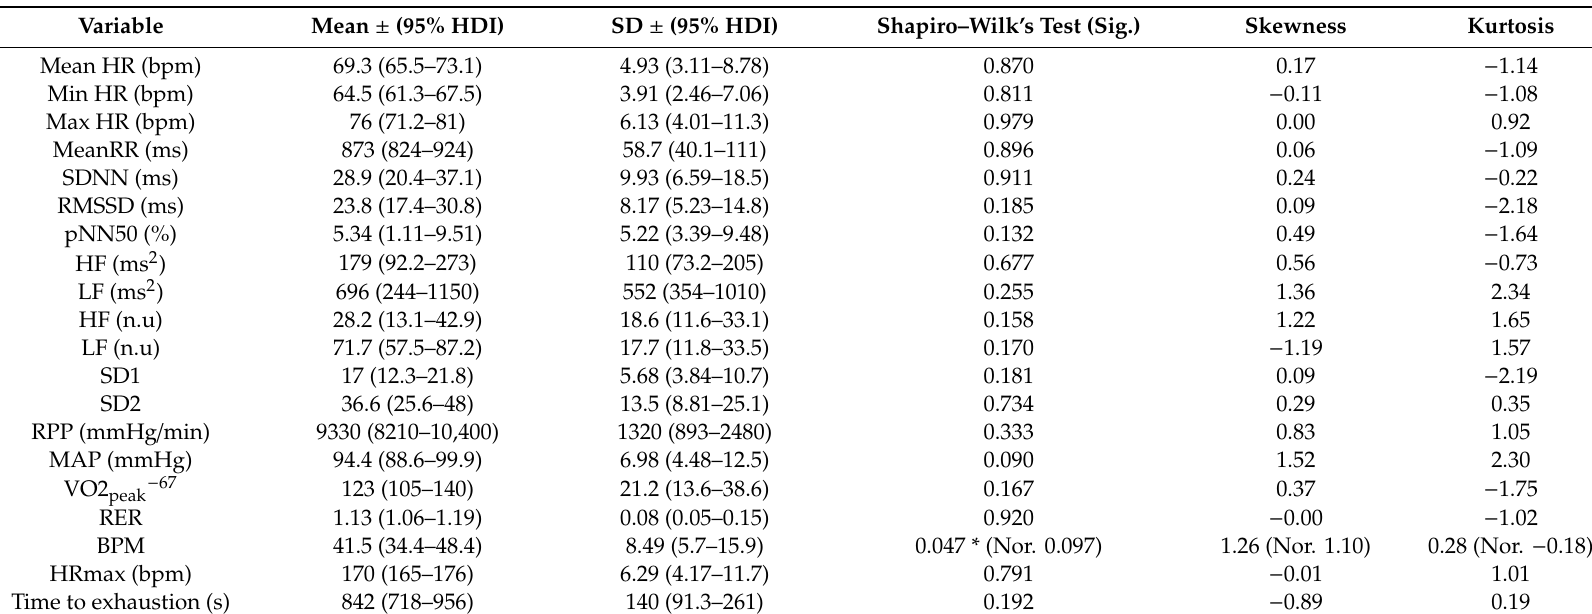
Table 4. Bayesian estimated mean and SD ± HDI, Shapiro–Wilk’s test, Skewness and Kurtosis of the raw